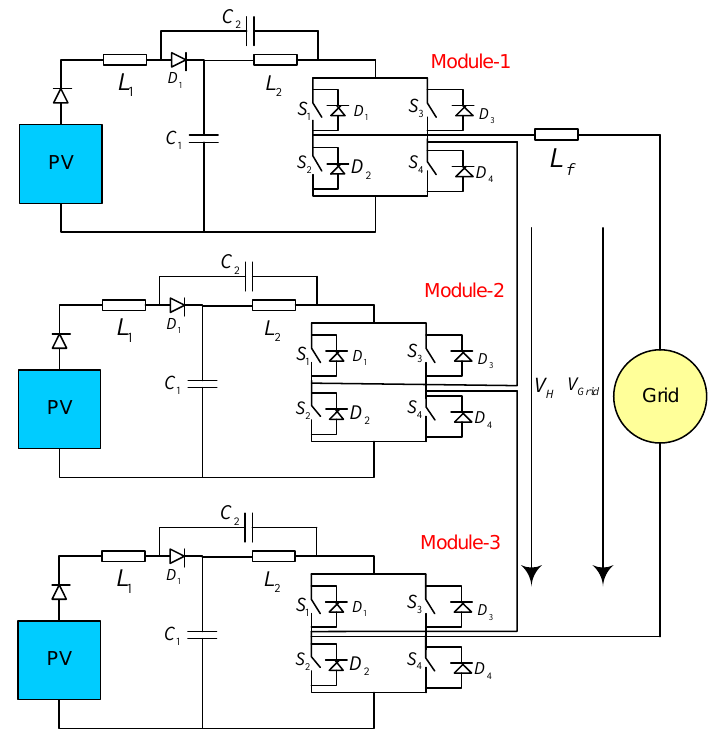
Figure 20. Seven-level qZSMLI with PV source